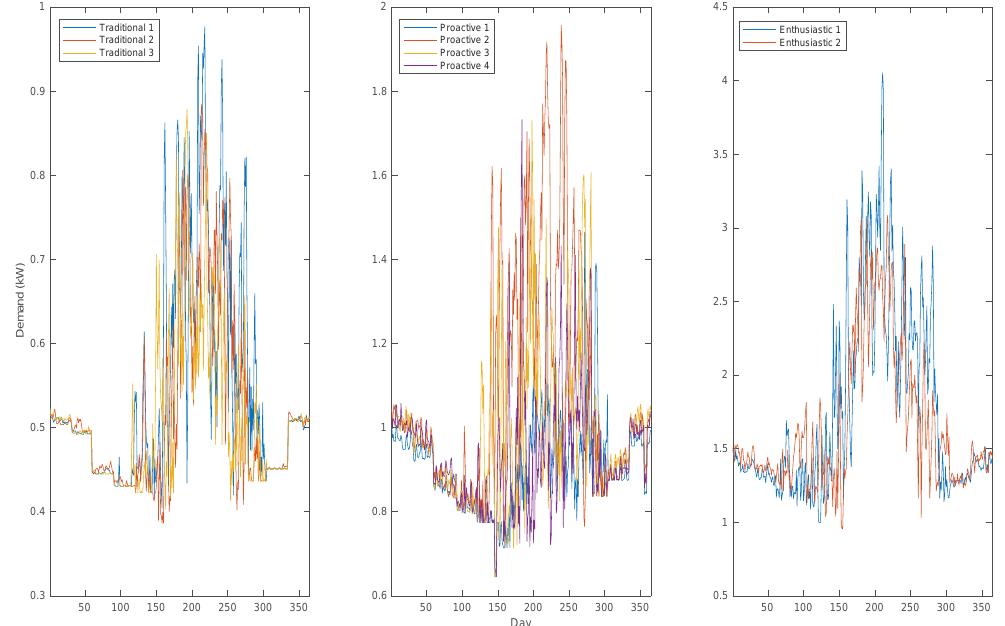
Figure 8. Yearly demand profiles of different houses in the